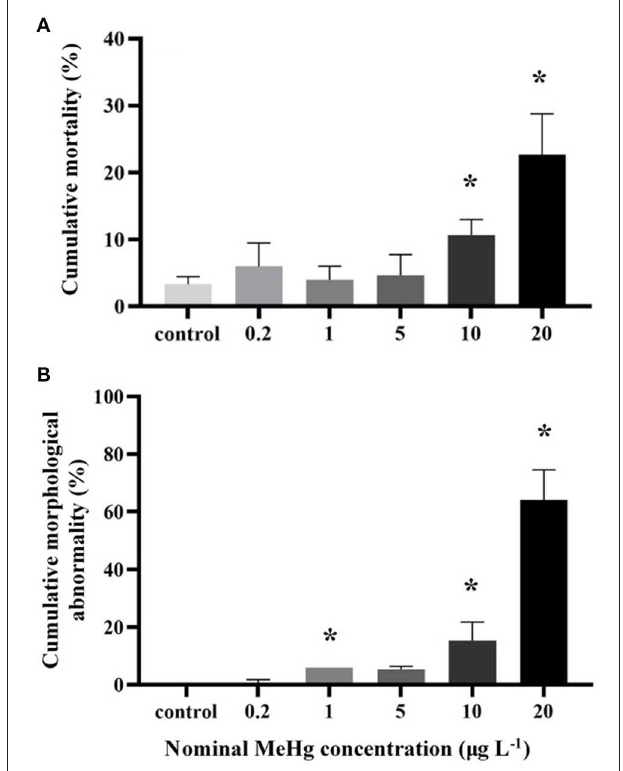
FIGURE 4 | (A) Cumulative mortality and (B) cumulative morphological abnormality of the large yellow croaker embryos and larvae by MeHg exposure (mean ± S.D.; n = 4; * indicated significant difference compared to the control group at p <